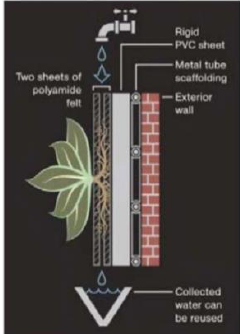
Figure 3 Schematic representation of rainwater management (Elgizawy Ebtesam,